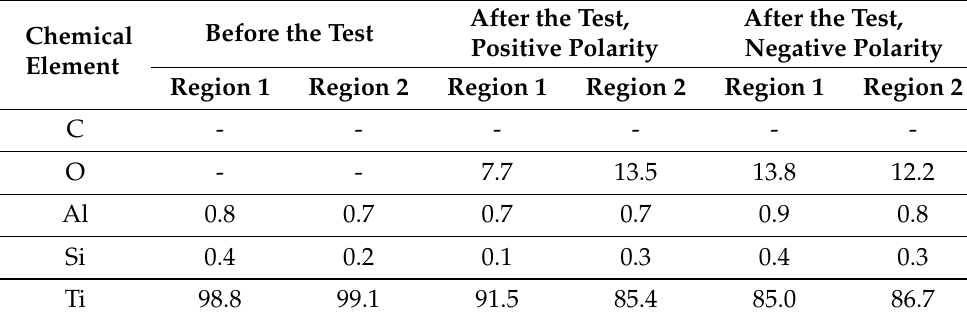
Table 3. Chemical composition of the rectangular electrodes before and after the test in the new regime with the positive and negative polarity of SP pulses. EDX analysis is performed at the regions marked by the black points in Figure